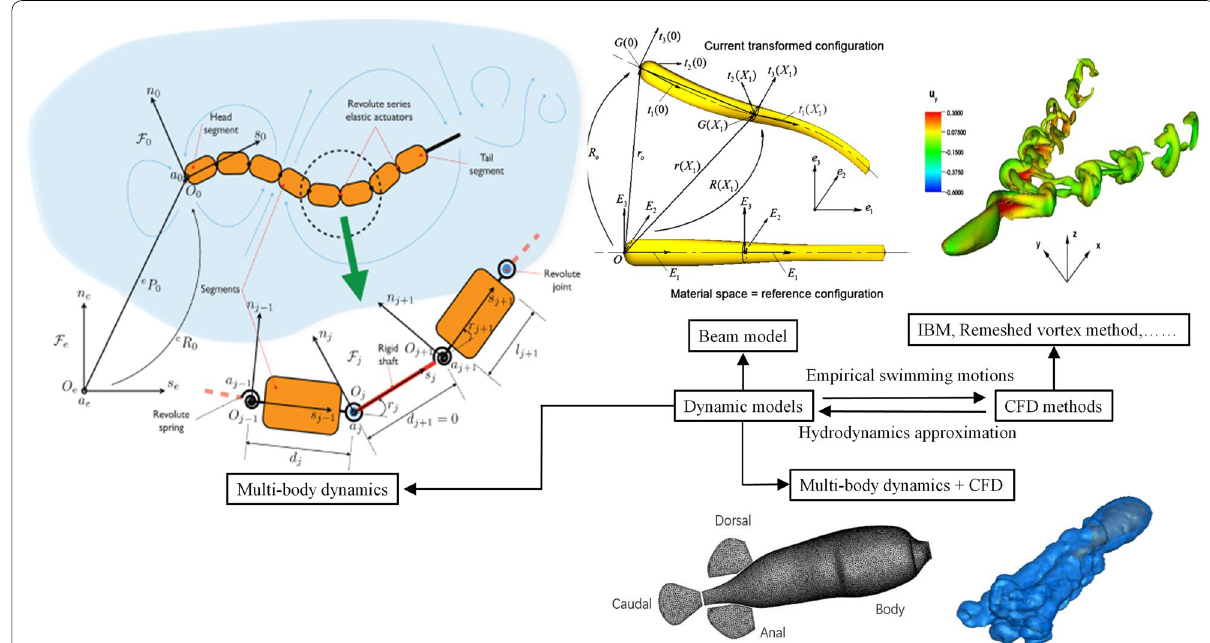
Figure 2 Simulation methods outline (The top left figure, top middle figure, top right figure and bottom figures are reproduced from Refs. [30], [31], [32] and [29],